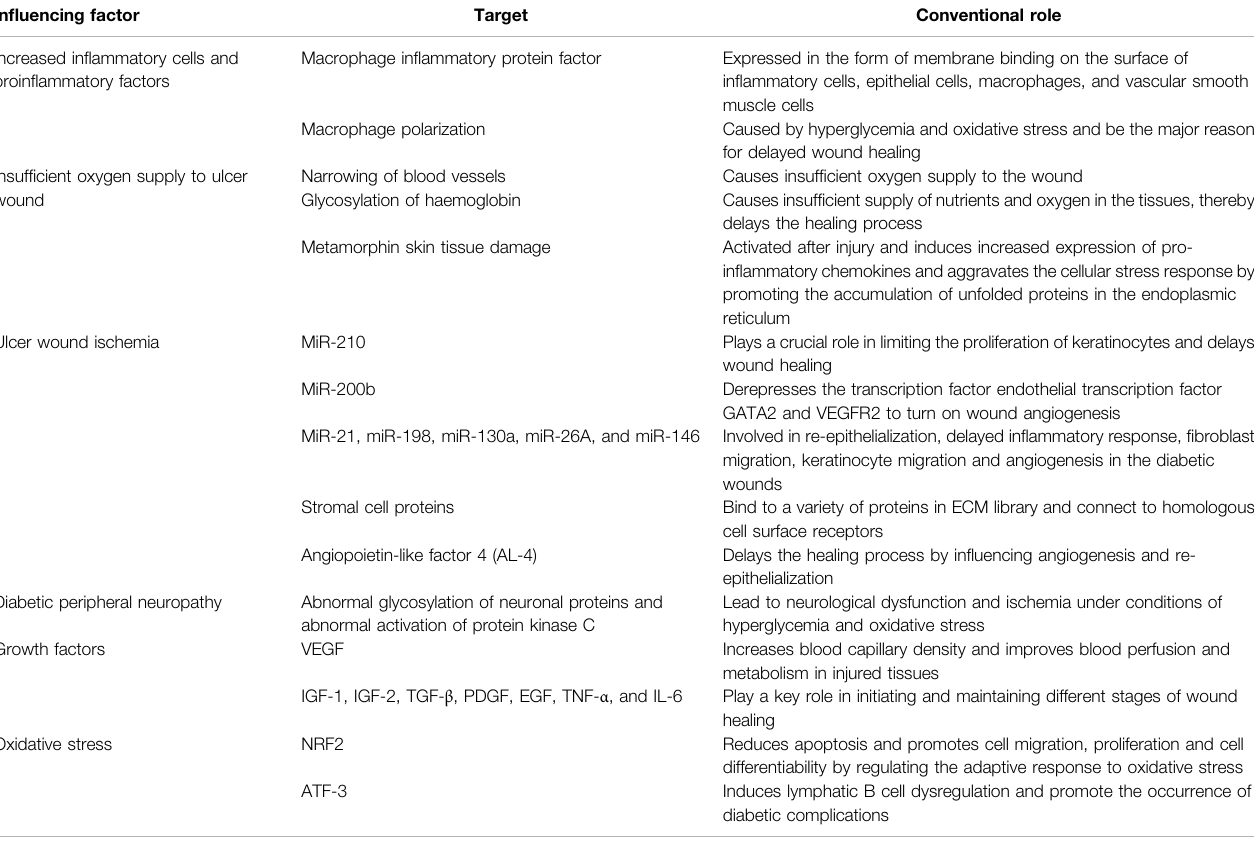
TABLE 1 | Pathogenesis of delayed wound healing of diabetic ulcers. In fl uencing factor